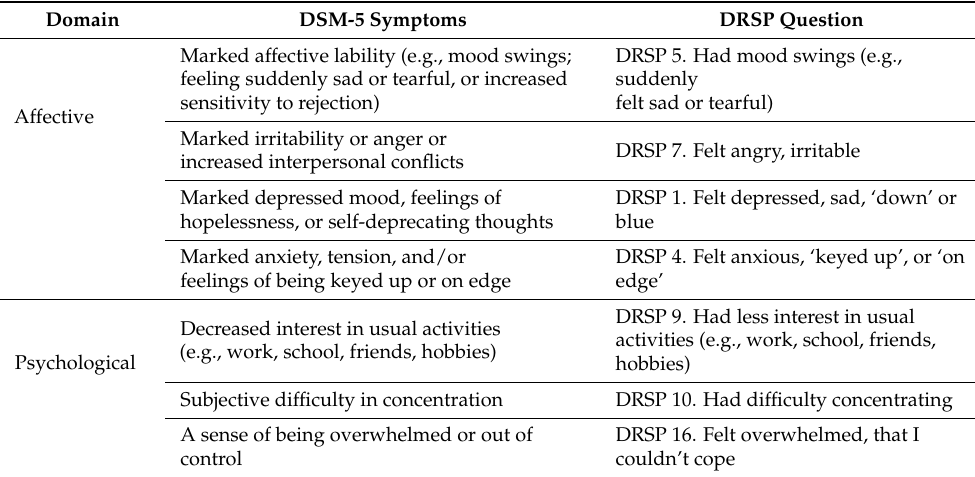
Table 1. Domain type and symptoms of PMS/PMDD as specified in DSM-5 in relation to DRSP Questions.